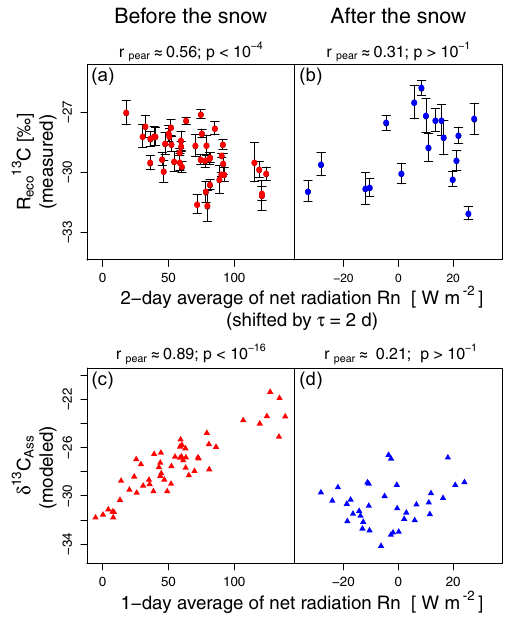
Figure 12. Observed relationships between net radiation R n , the measured isotopic composition of ecosystem respiration R 13 eco C (a, b) and the modeled 13 C composition of assimilated material δ 13 C Ass (c, d) . Significant correlations were observed before the first snow (a, c) but became insignificant after the snow (b, d) . r pear and p values are derived from the respective linear